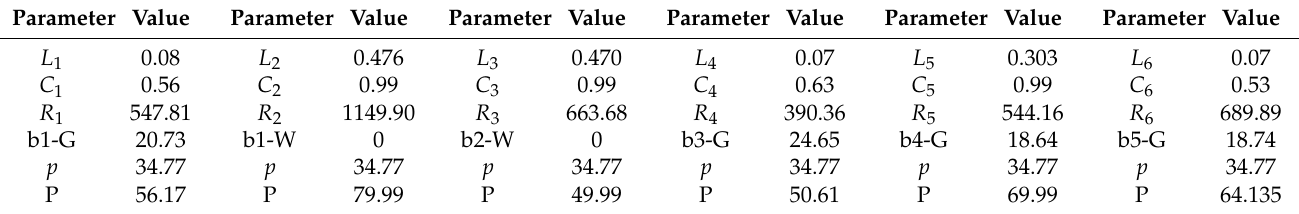
Table 5. Results of other training parameters of Table 6. Results of other training parameters of DDPG.